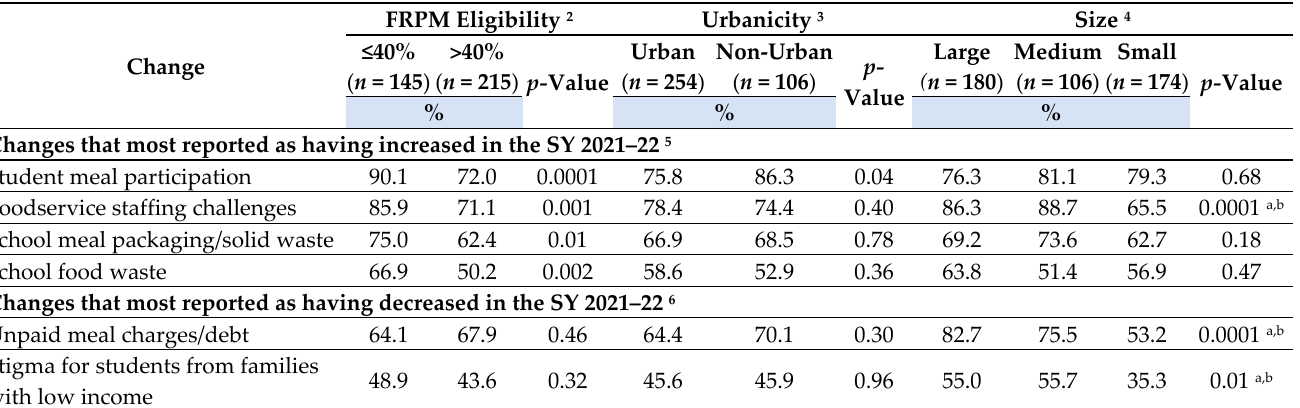
Table 3. Frequency of changes reported after implementing universal school meals in the SY 2021–22